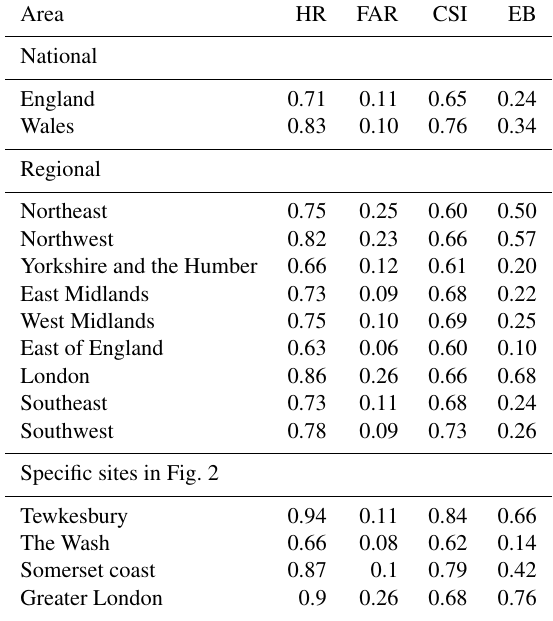
Table 2. Validation metrics when comparing the 1-in-100-year re- turn period fluvial and 1-in-200-year coastal hazard layer from the model developed in this paper to equivalent government flood maps in England and Wales. The four validation metrics are hit rate (HR), false alarm ratio (FAR), critical success index (CSI) and error bias (EB). For further details on how these are computed, see Eqs. (1)– (4) and Table